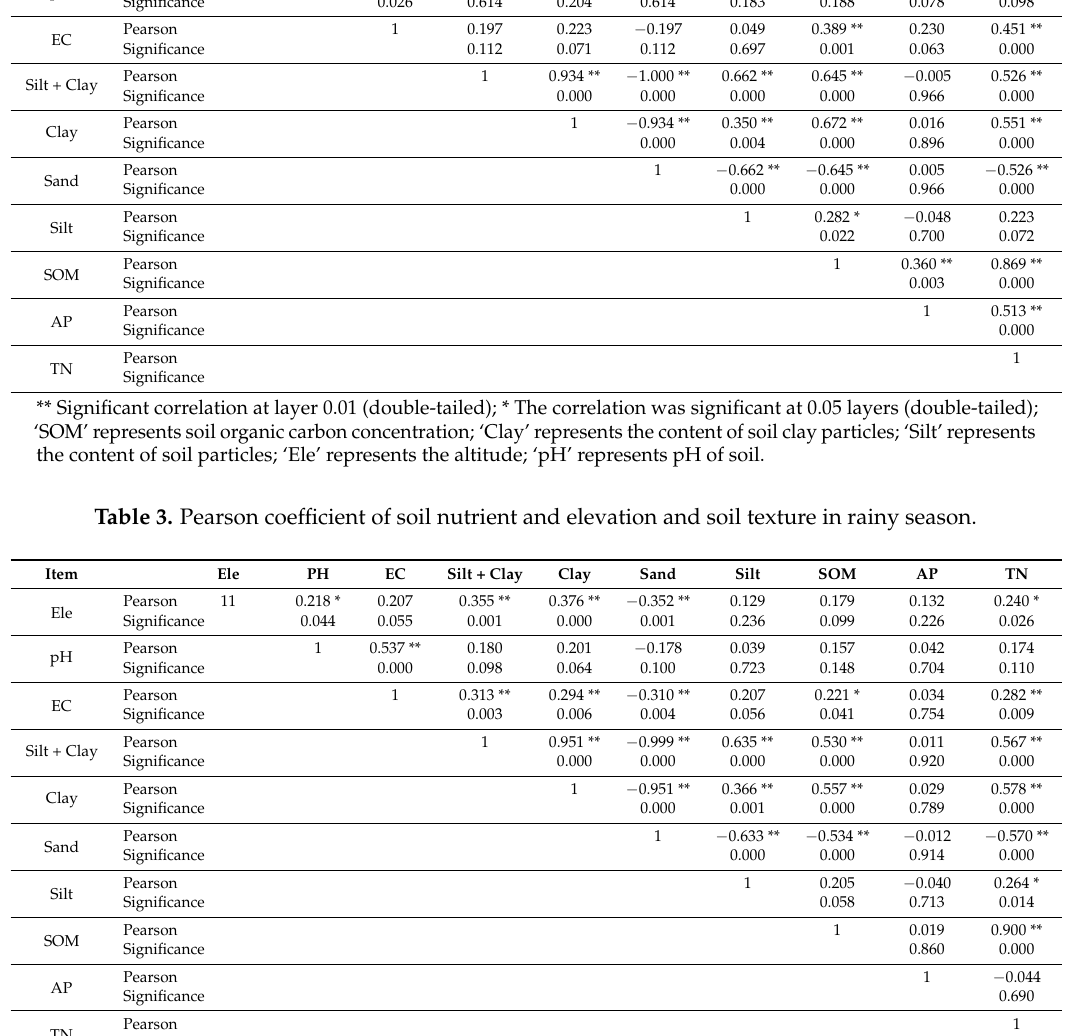
Table 2. Pearson coefficient of soil nutrient and elevation and soil texture in dry season.